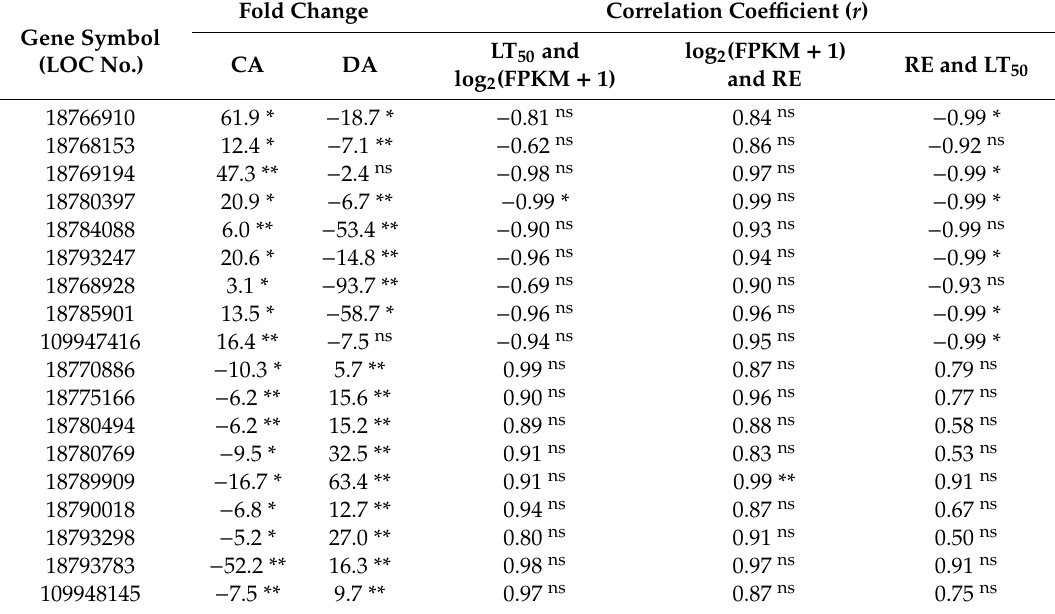
ns, * , ** not significant or significant at p < 0.05 or 0.01, respectively, using the Student’s t -test.